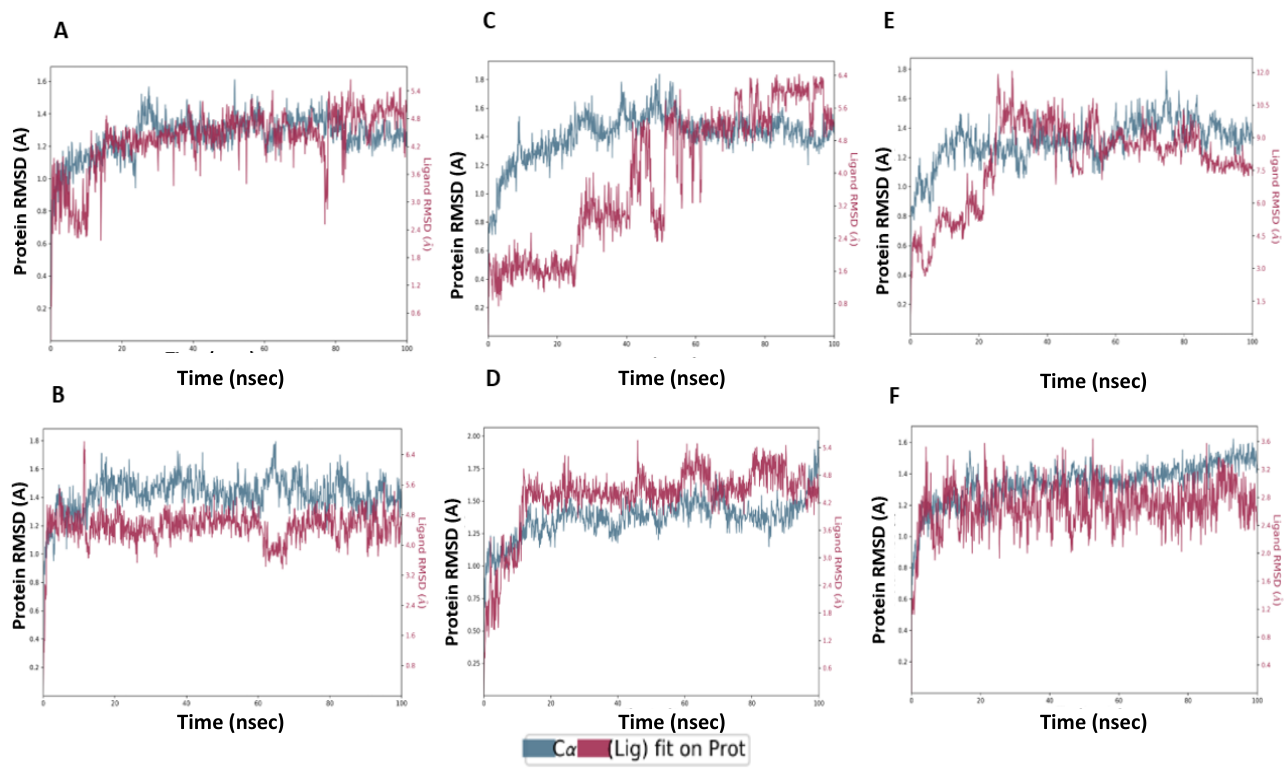
Figure 10. The root mean square deviations (RMSD) plots of compounds M1–5 compared to Compound 13 with human TMPRSS2 (PDB ID: 2OQ5). ( A ) RMSDs of Compound 13 . ( B ) RMSDs of M3 . ( C ) RMSDs of M1 . ( D ) RMSDs of M2 . ( E ) RMSDs of M4 . ( F ) RMSDs of M5 . Green represents the protein backbone fluctuations, while the red represents the ligand